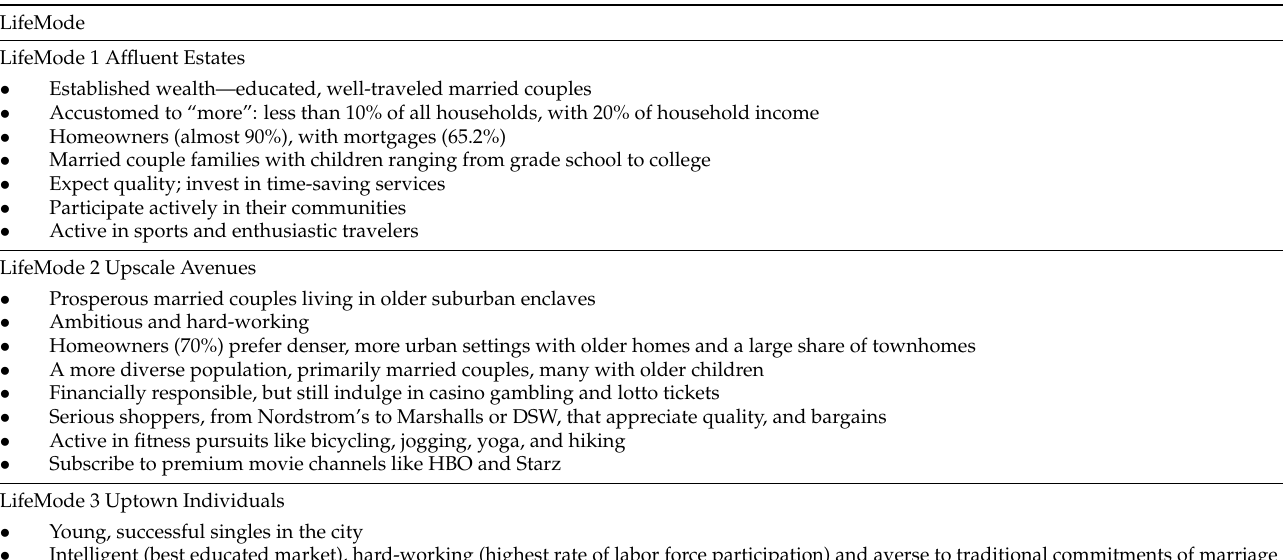
Table A1. Description of